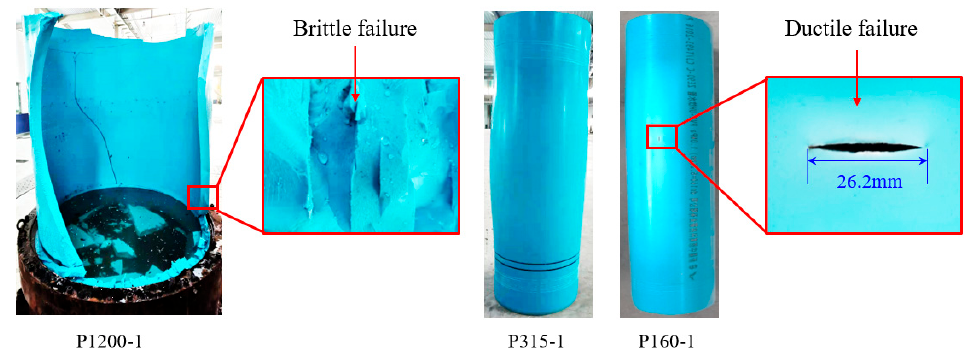
Figure 13. Typical specimen failure of short-term burst